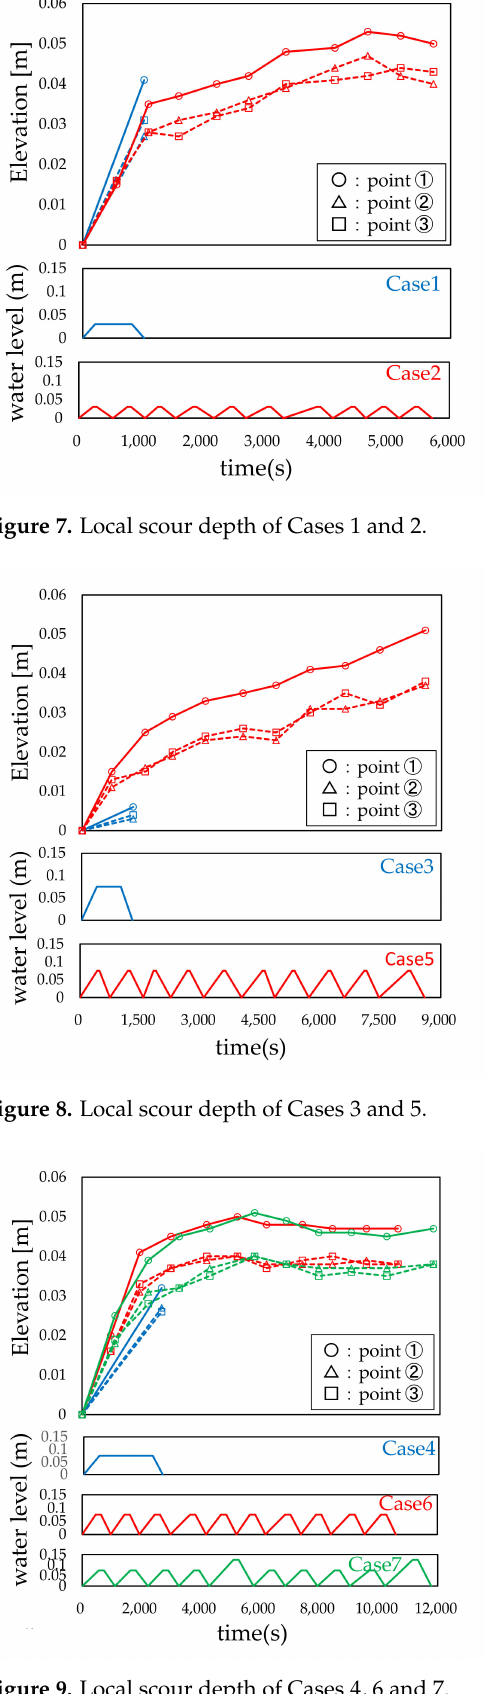
Figure 9. Local scour depth of Cases 4, 6 and